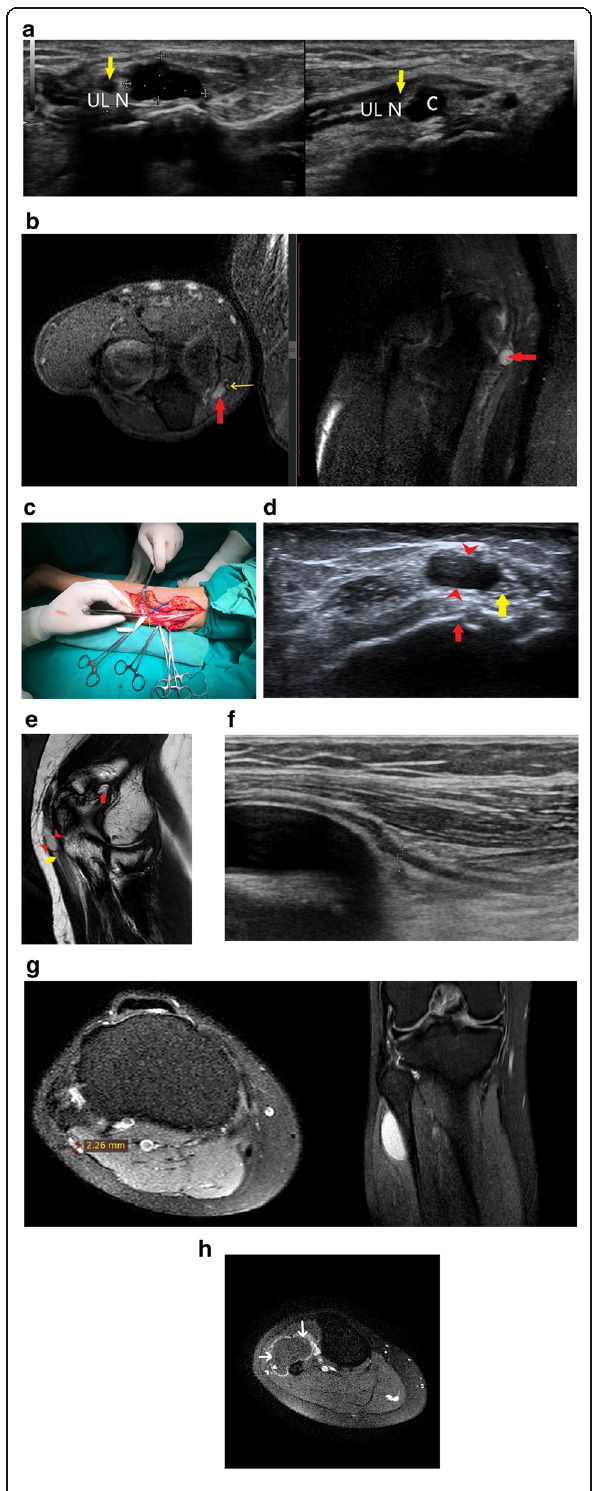
Fig. 8 a Hypoechoic radial nerve (point A and B) is seen entrapped within mixed echogenic chronic inflammatory soft tissue (5 point and 6 point star). Malunited fracture of humerus can be seen adjacent to it (arrowheads). b Plain radiograph showing malunited, displaced fragment of supracondylar fracture of humerus. c Hyperintense radial nerve (black arrowhead) with surrounding hyperintense muscle oedema can be seen on this axial PDFS